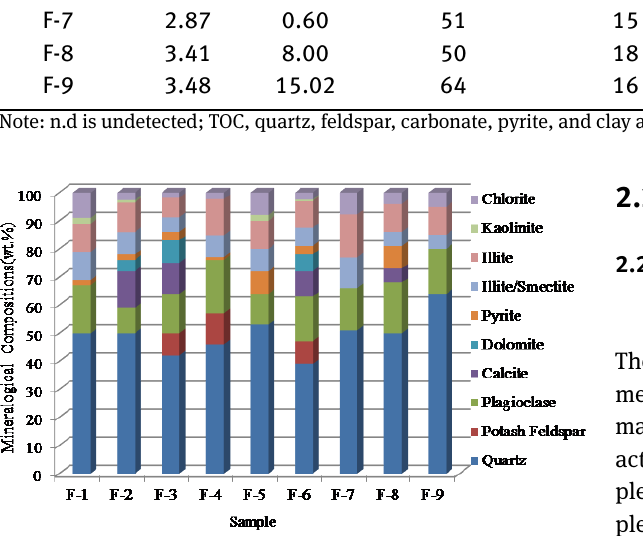
Figure 2: Quantitative analysis results of clay minerals in